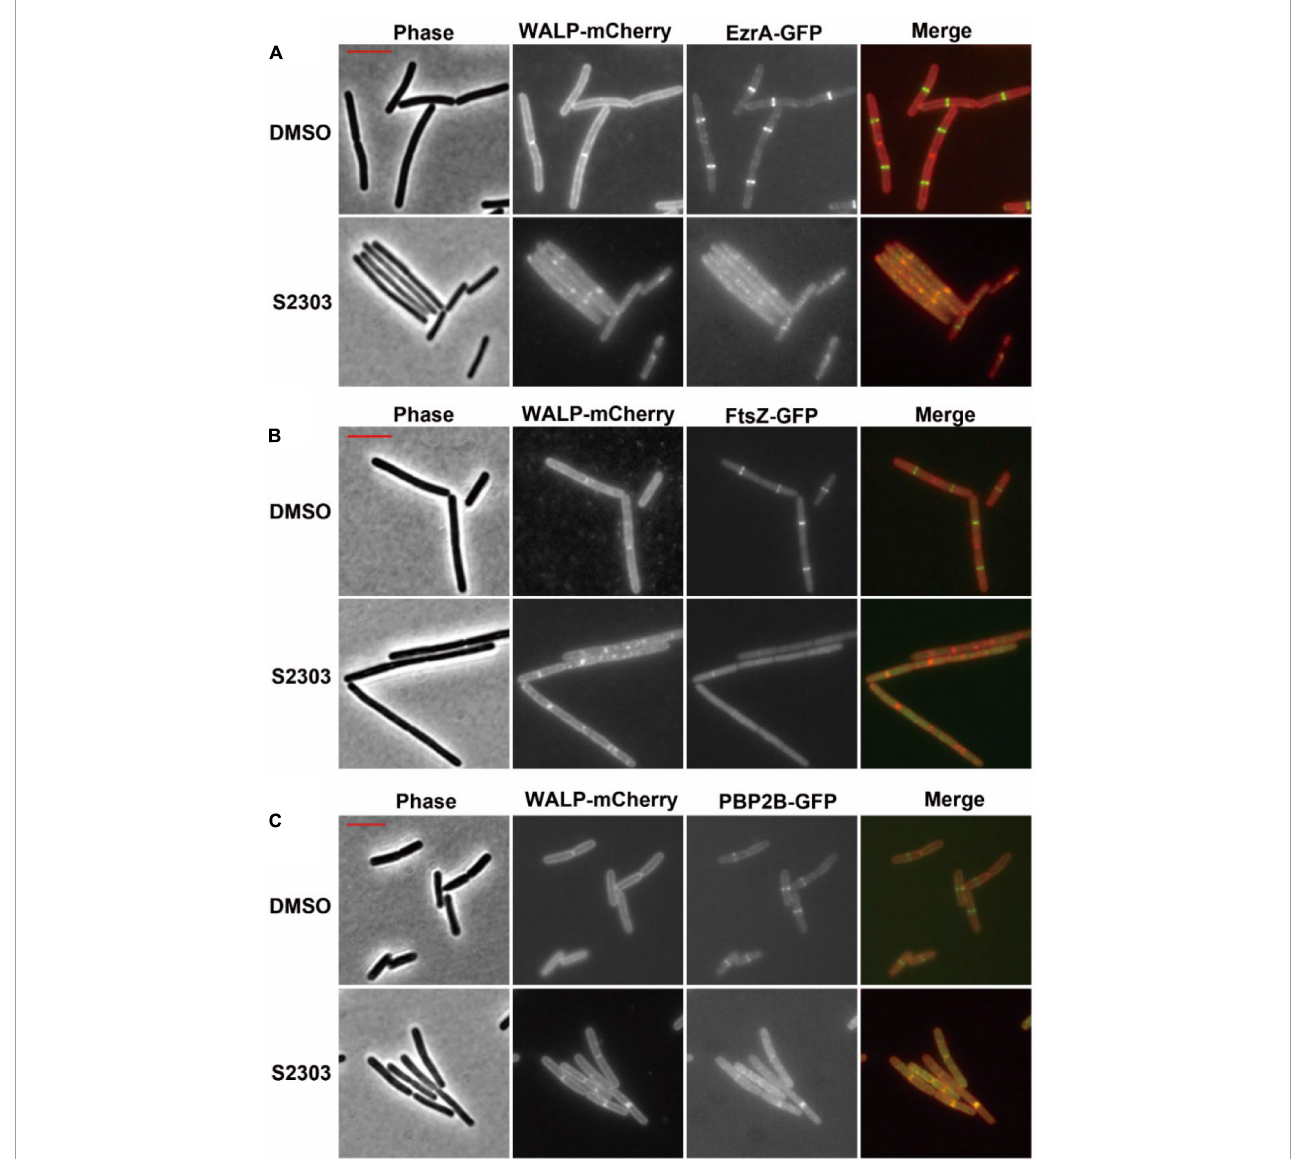
FIGURE4 Effects of S2303 on the localizations of (A) EzrA, (B) FtsZ, and (C) PBP2B. The division proteins are fused to GFP (EzrA-GFP or PBP2B-GFP), while membranes are labeled by WALP-mCherry. In the merged images, membranes are shown in red and GFP in green. Cells (OD 600 = 0.05) were incubated in 1/5 LB media with 4 µ g/mL S2303 or Dimethyl sulfoxide (DMSO) [1% (v/v), “Untreated”] for 10 mins. The scale bar is 5 µ m and in color of